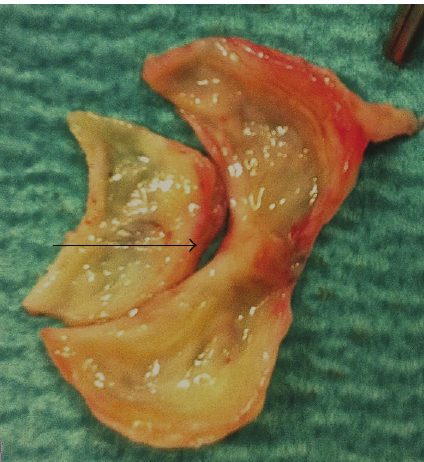
Figure1:Photographofexcisedthickenedtrileafletaorticvalvewith retracted right coronary cusp (arrow) and fusion of the other two leaflets at the commissure.